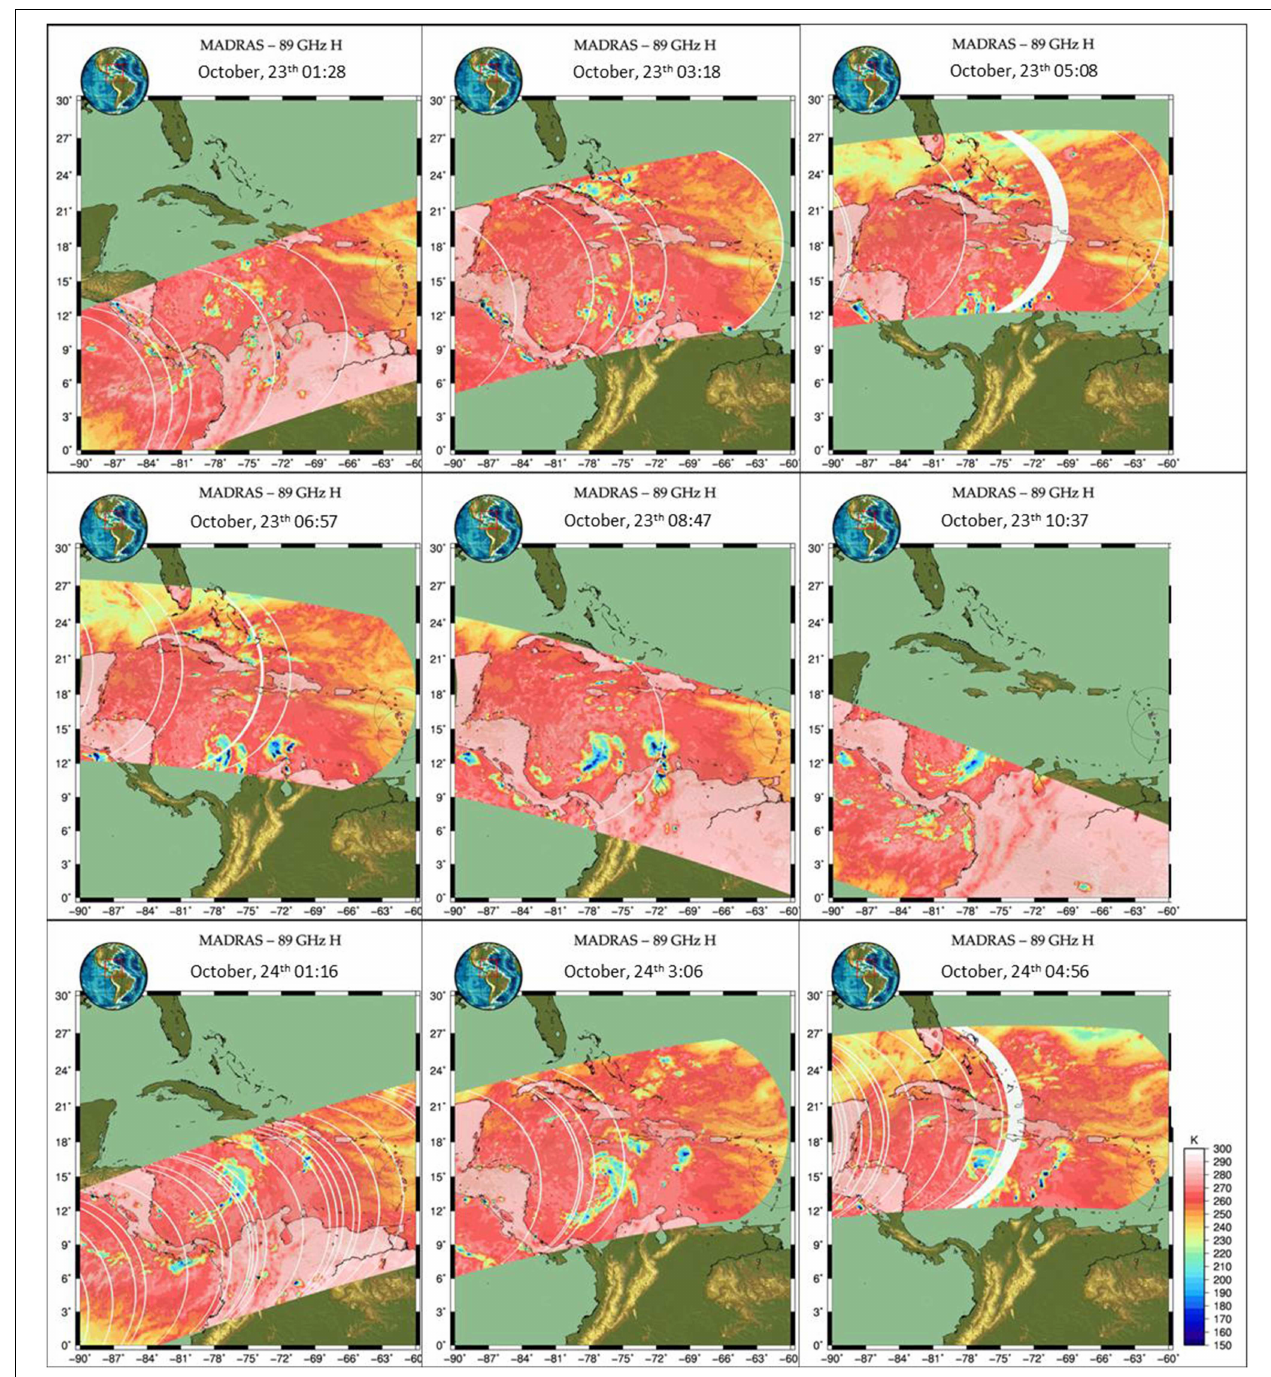
FIGURE 9 | Time series of MADRAS 89GHz observations of Hurricane Sandy from October 23 to 24, 2012.